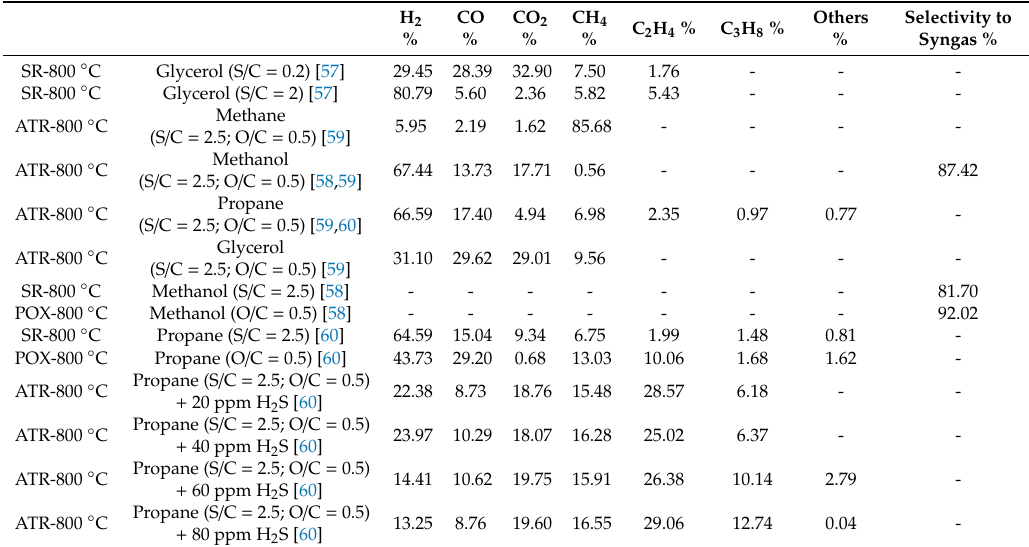
Table 1. Survey of the average product formation achieved in di ff erent reaction processes at 800 ◦ C. Data from